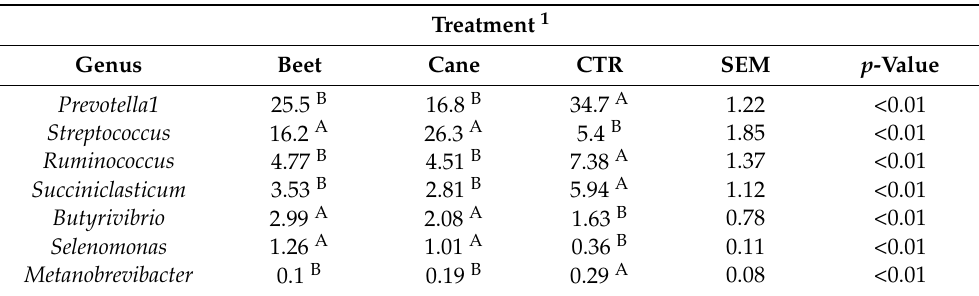
Table 5. Rumen genus-level microbial composition in beet, cane, and CTR groups at 24 h of incubation. For each family, the relative abundance (% of the total) is